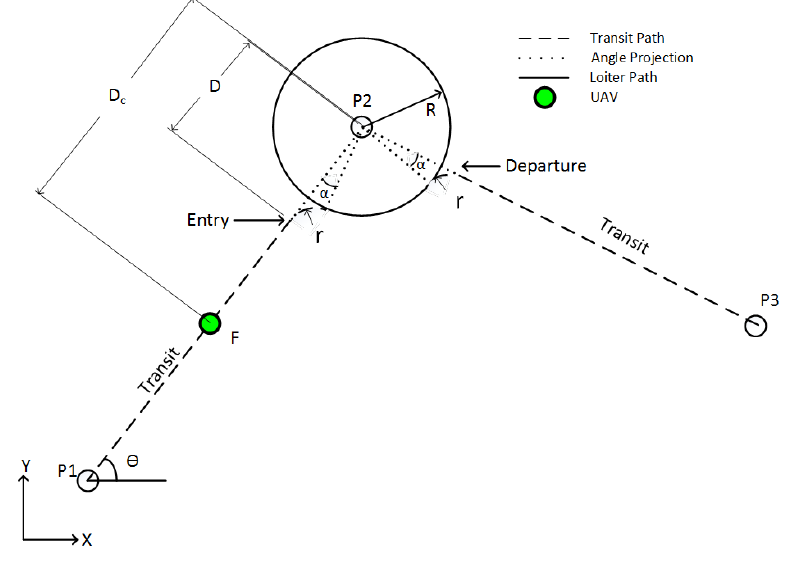
Figure 10. Least distance smart loiter transit, entry, loiter, departure